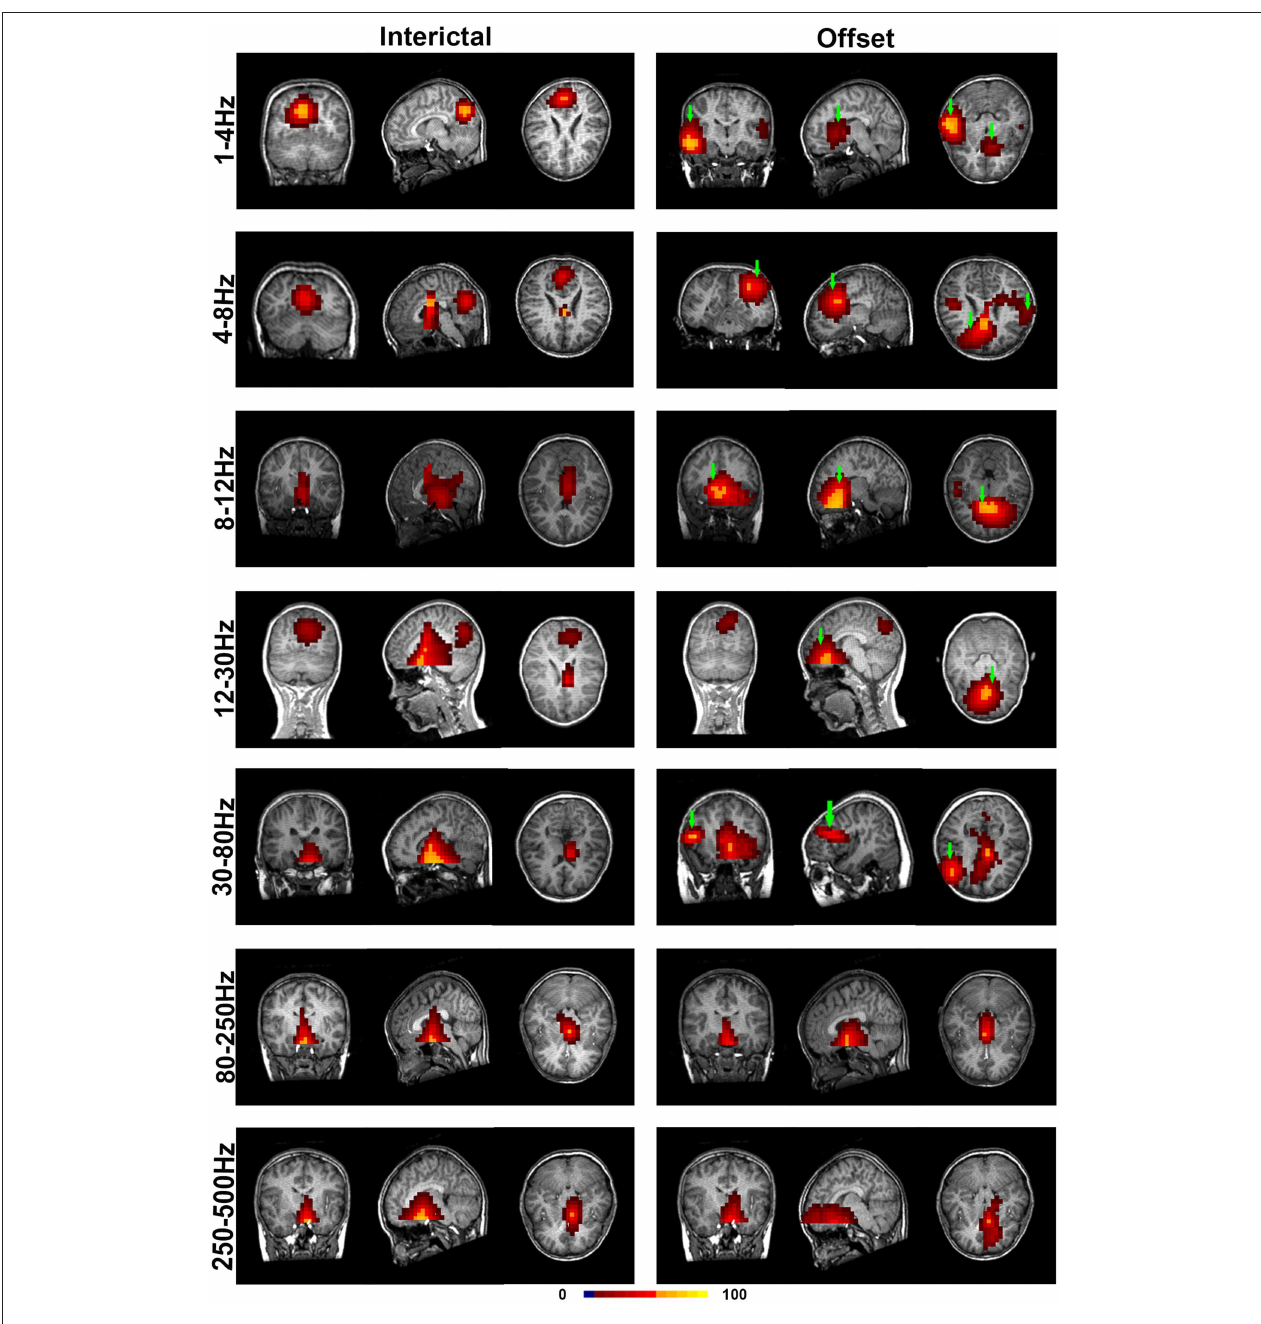
FIGURE 2 | Accumulated source images of the interictal and termination transition periods showing spatial activities in seven pre-defined frequency bands recorded from CAE subjects. In comparison to the interictal periods, significantly altered patterns of source imaging were observed during termination transition periods in five lower frequency bands. Green arrows point toward the regions that show the activation only in the offset transition periods but not the interictal periods. The color bar indicates the color coding of the level of